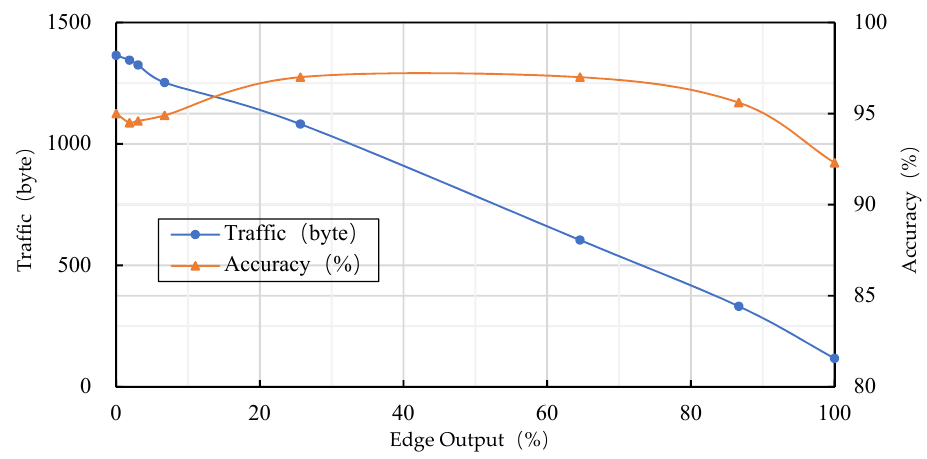
Figure 12. Variation in traffic and accuracy with edge output rate.